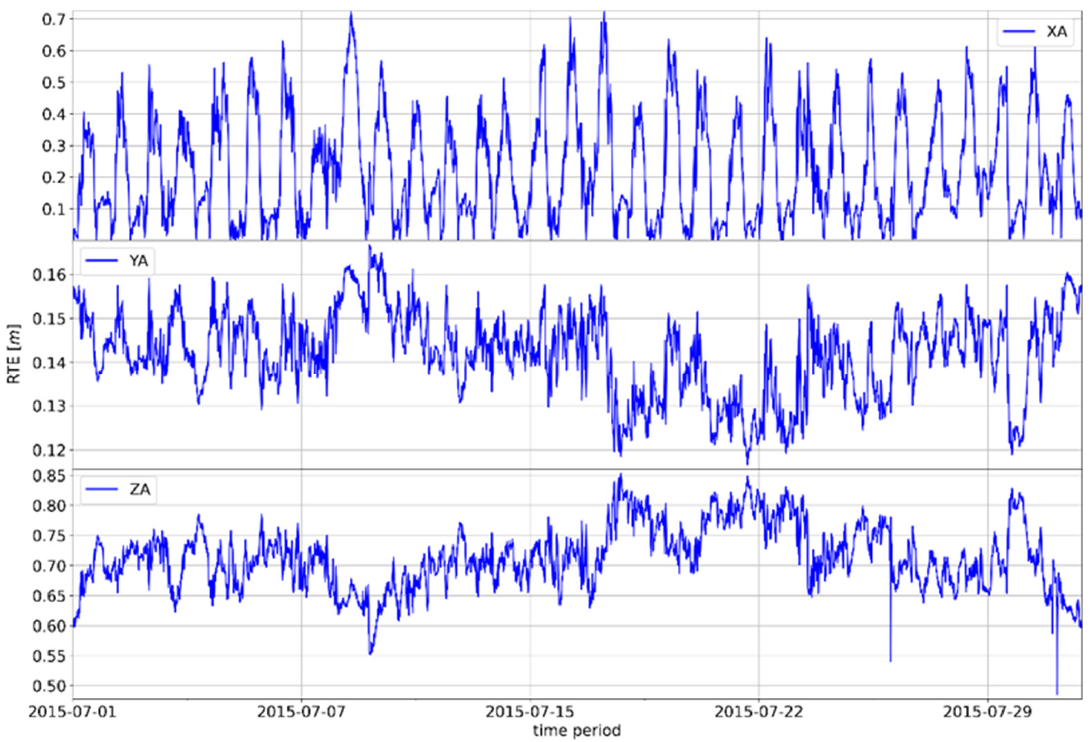
Figure A5. Movement of the absolute difference of the RTE GNSS position parameter in Zadar, July 2015.